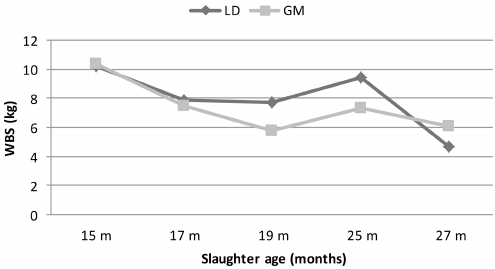
Figure 2. Changes in Warner–Bratzler shear (WBS) force values of LD and GM muscles depending on different slaughter